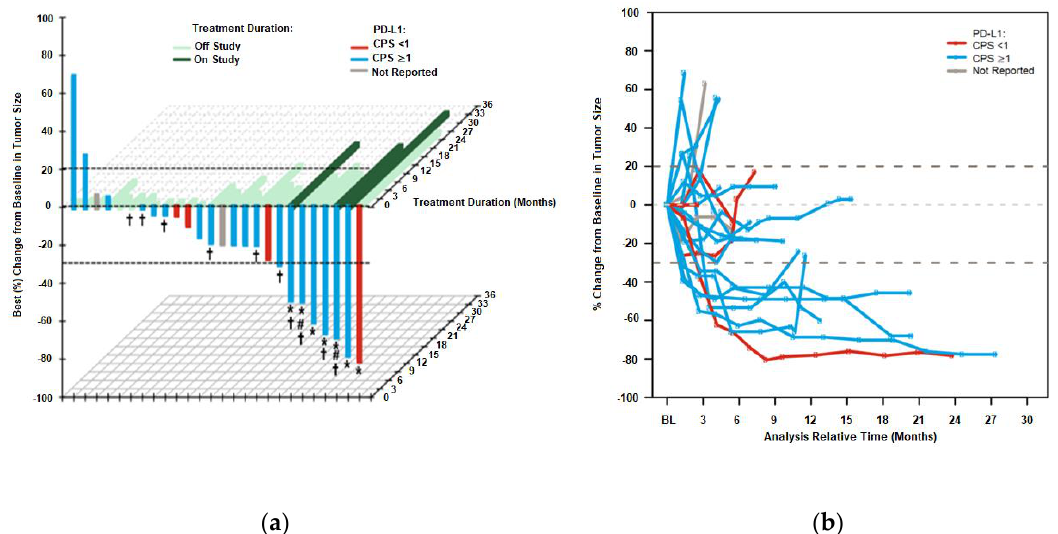
Figure 1. ( a ) Best percentage change of targeted lesions from baseline versus treatment duration. Patients ( x -axis) are arranged by percentage change in size of targeted lesions from baseline ( y -axis) and color-coded for best response according to PD-L1 expression. Treatment duration (green) is shown on the z -axis. Dotted lines indicate RECIST boundaries (20% to 30%); ( b ) Change in tumor burden by PD-L1 status over time. PD-L1-positive is equivalent to CPS ≥ 1 and PD-L1-negative is equivalent to CPS < 1. Abbreviations: BL, baseline; CPS, combined positive score; PD-L1, programmed death-ligand 1. * Confirmed response. # Microsatellite instability high. † CPS ≥